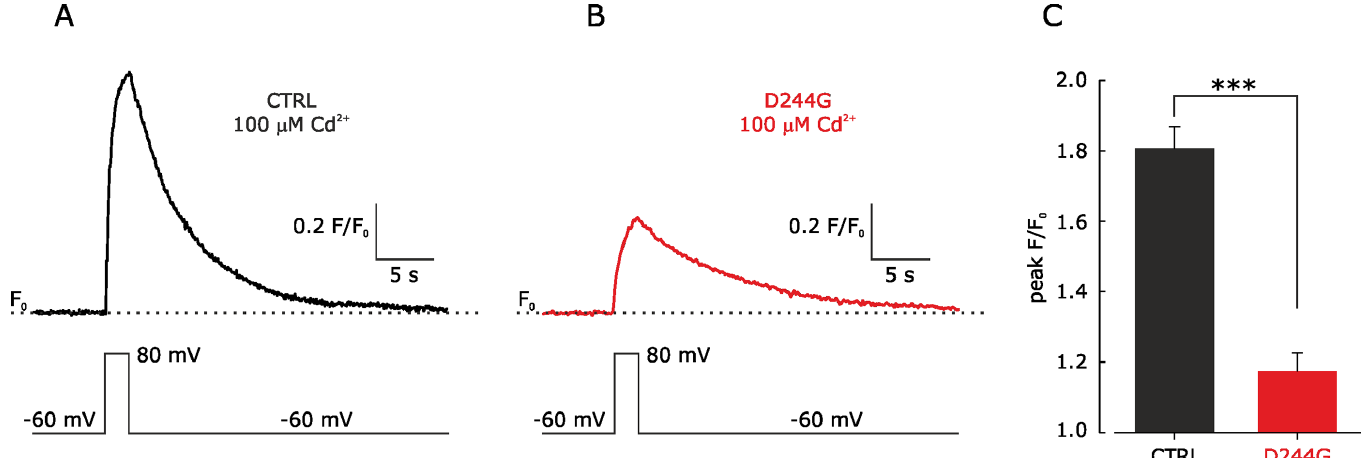
Fig 6. Sarcoplasmic Ca 2+ signals elicited by depolarization in control vs D244G myotubes. Representative fluorescence traces elicited by depolarization to +80 mV (in the presence of CdCl 2 100 μ M) from Fluo-4AM-loaded control ( A , CTRL) and patient ( B , D244G) myotubes. The voltage-clamp steps applied to myotues are shown below each sample trace. ( C ) Bar graph showing the mean Ca 2+ signals elicited from control ( black ) and D244G ( red ) myotubes (the data are mean ± SEM; n = 5; *** p <